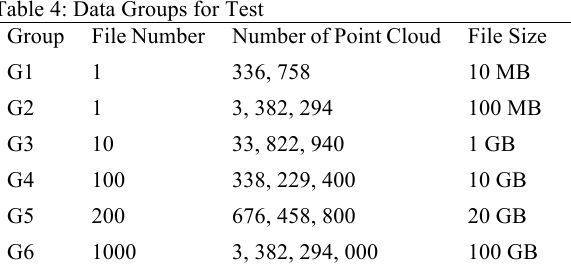
Figure 4. Converted pcd Format, Visualization in PCL Viewer Table 4: Data Groups for Test